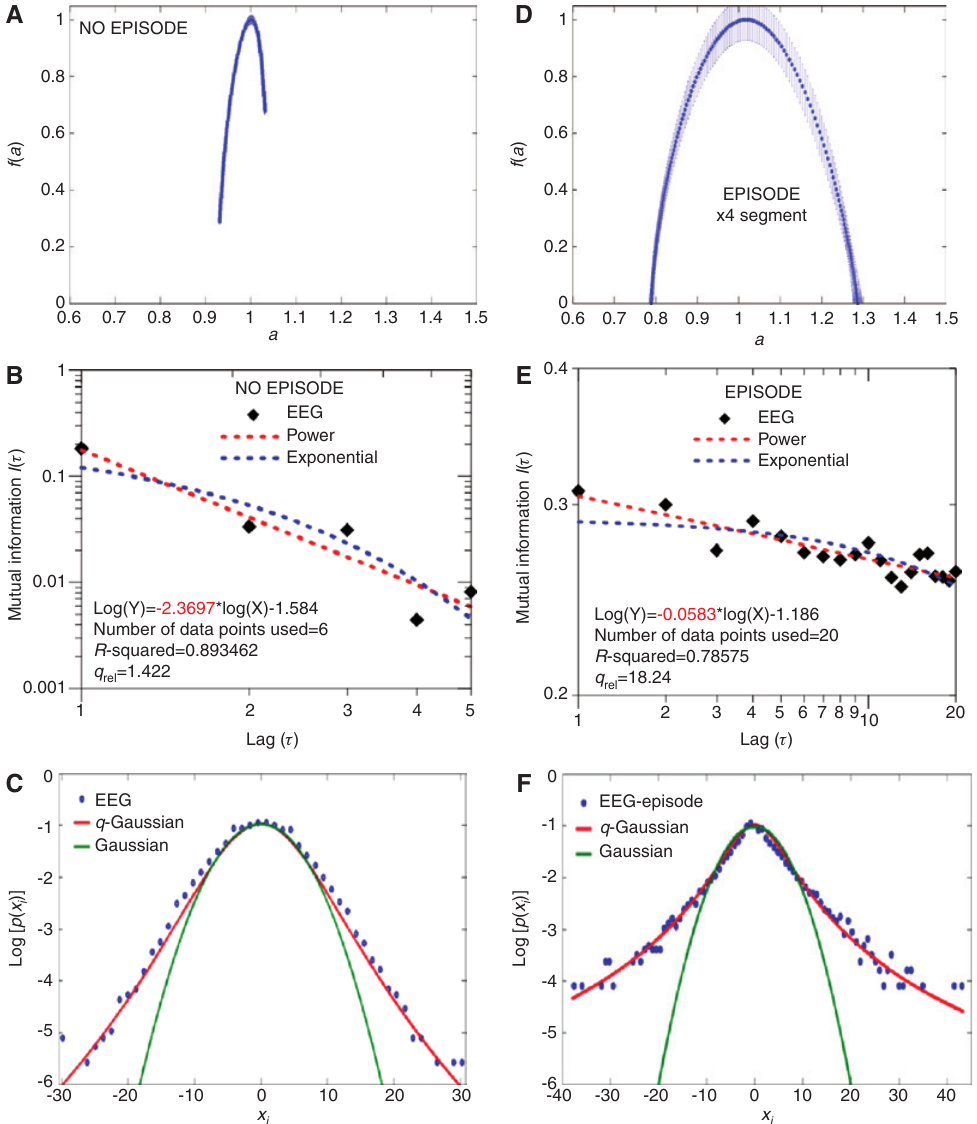
Figure 2: Results concerning the two time